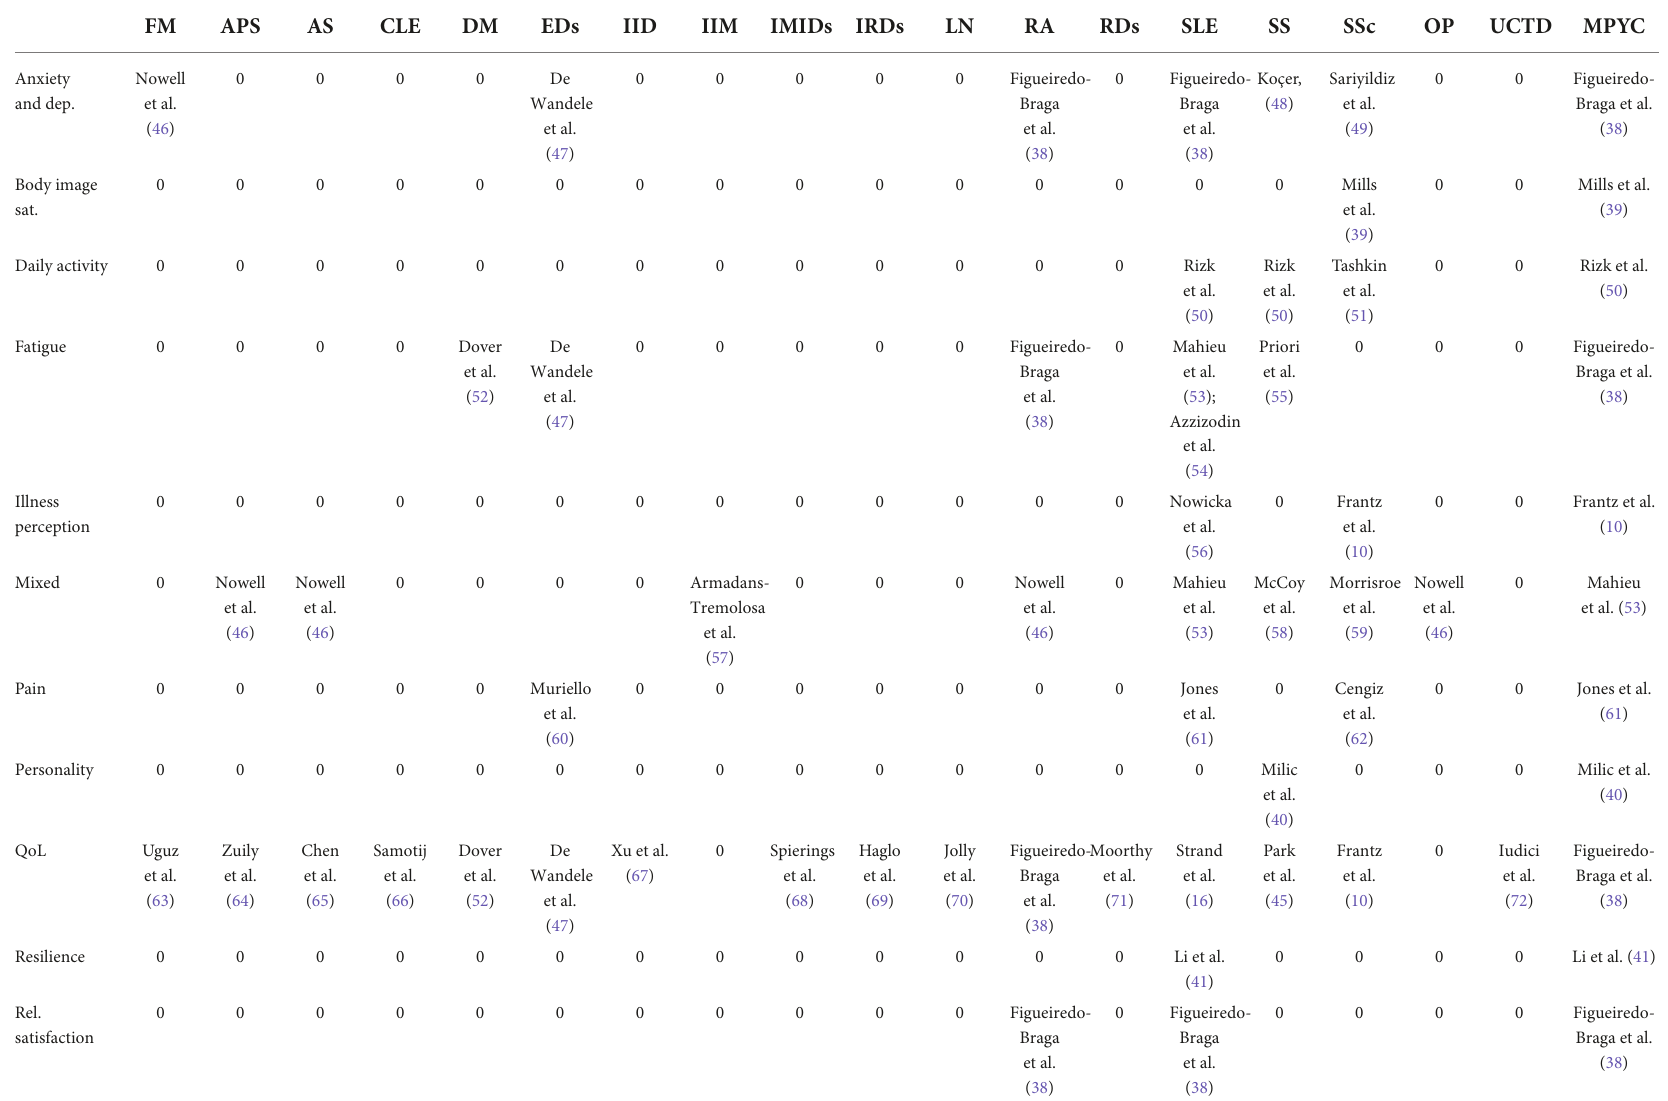
TABLE 1 Most cited and relevant papers per patient reported outcome domain and